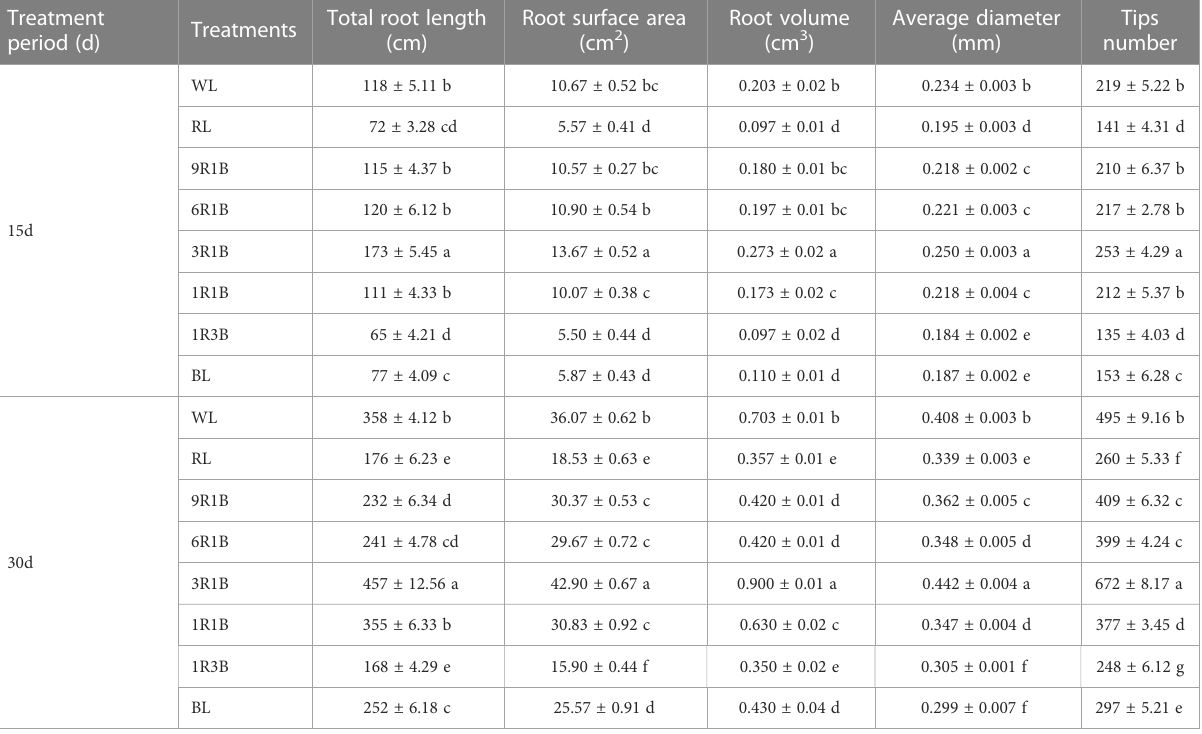
Data are presented as means ± SE, n = 5. Different letters indicate signi fi cant differences between values (P < 0.05). WL, white light; RL, monochromatic red light; BL, monochromatic blue light; 9R1B, mixed RL and BL of 9:1; 6R1B, mixed RL and BL of 6:1; 3R1B, mixed RL and BL of 3:1; 1R1B, mixed RL and BL of 1:1; 1R3B, mixed RL and BL of 1:3.